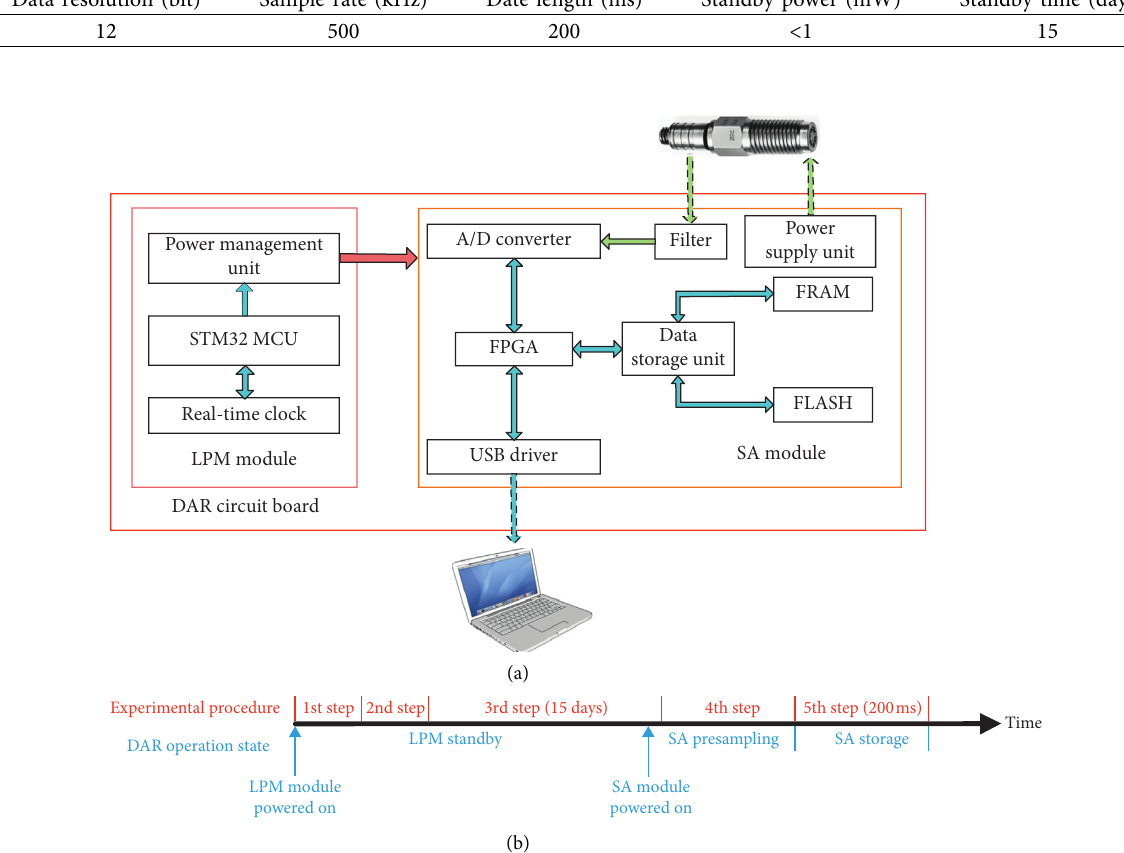
Figure 4: DAR circuit. (a) Schematic structure of the DAR circuit. (b) Relationship between the experimental procedure and the DAR operation